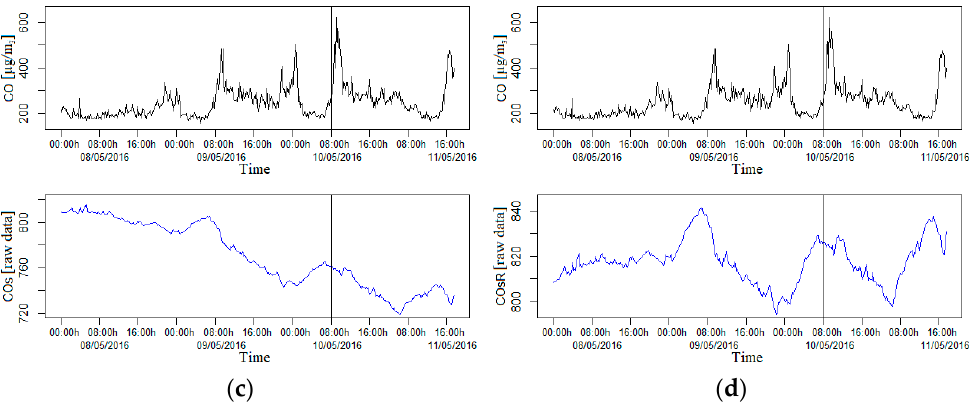
Figure 3. ( a – d ) Plots of the evolution over time of the indicated gaseous pollutants in black lines for the patterns and in blue lines for the sensors (and for the transformation of the variable COs, COsR). Each vertical line separates the training dataset (on the left) from the test dataset (on the right).